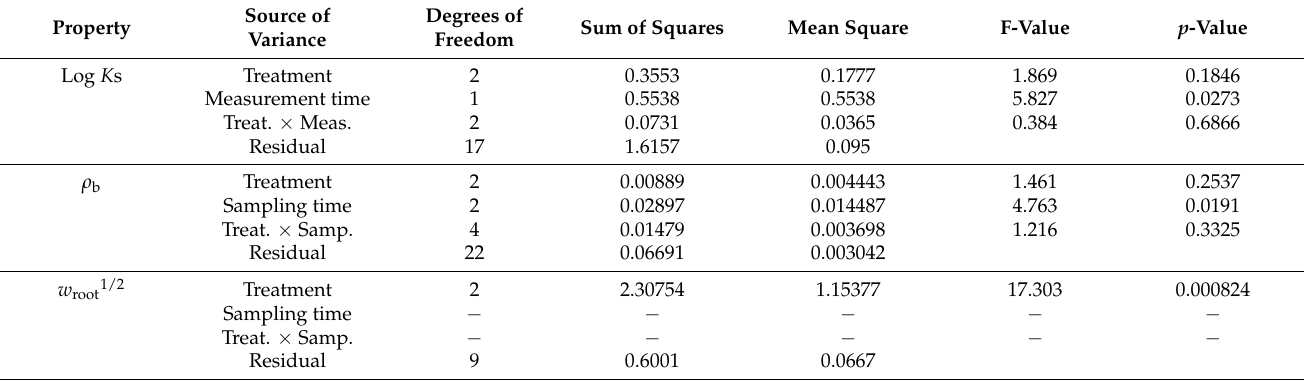
Table 3. Two-way analyses of variance of the properties studied in this work 1 , except for w root1/2 for which the one-way ANOVA is